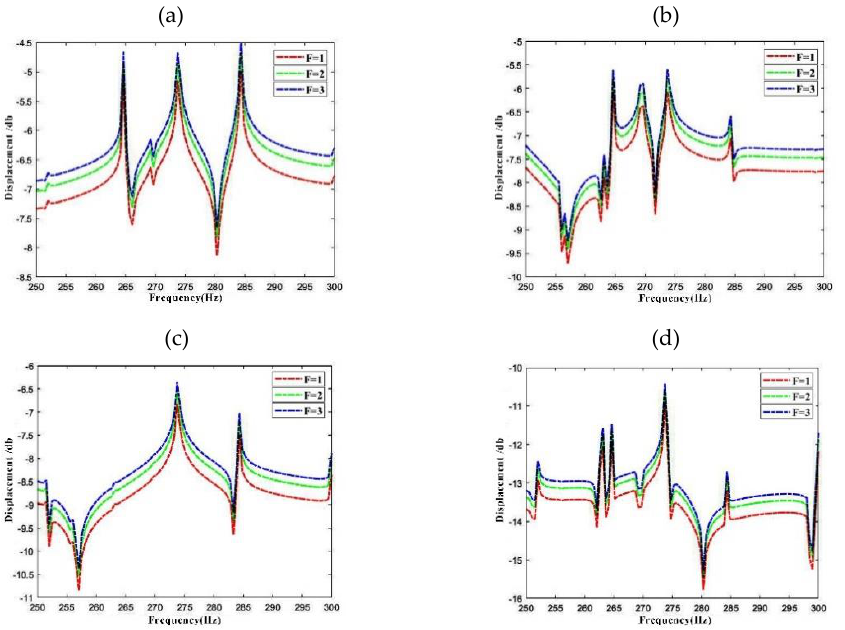
Figure 10. Variation of response vibration frequency for LCDCSS with various external excitation amplitude. ( a ) Point 1#; ( b ) Point 2#; ( c ) Point 3#; ( d ) Point 4#.